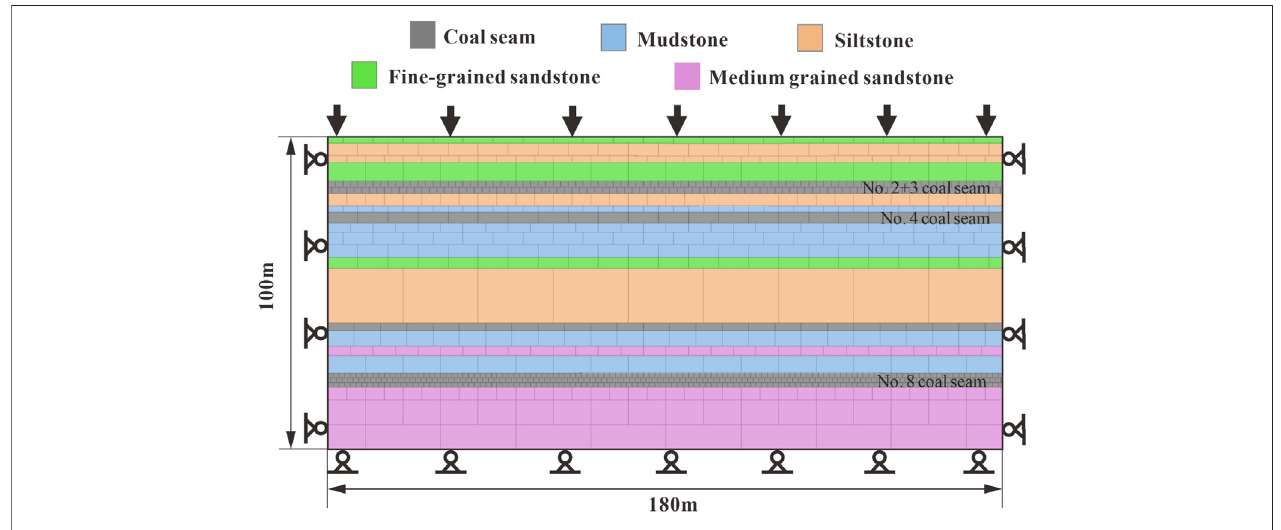
FIGURE 7 | Numerical simulation model for No. 18401 Panel.